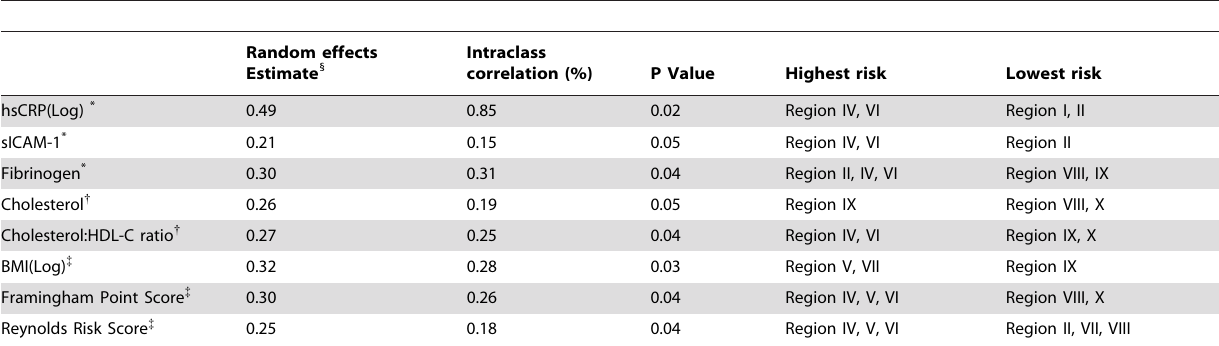
Table 3. Standard Federal Regional-level Variation in Cardiovascular Inflammation, Cholesterol, BMI and Cardiovascular Risk